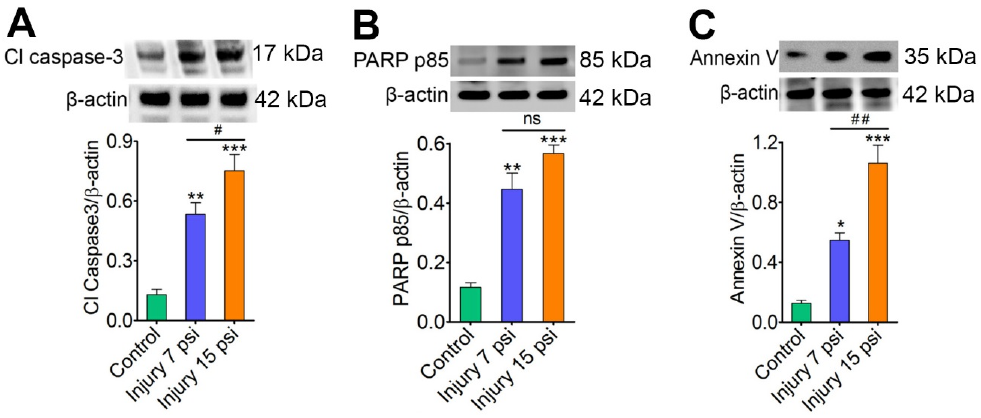
Figure 1. TBI induces apoptosis via caspase ‐ 3 in vivo: ( A–C ). Western blotting of cleaved caspase ‐ 3 ( A ), cleaved PARP (PARP p85) ( B ) and annexin V ( C ) in the brain cortex tissue lysates from uninjured control and FPI animals (7 psi and 15 psi) 9 days after injury. Values are mean ± SEM; n = 4. * p < 0.05, ** p < 0.01, *** p < 0.001 versus uninjured control; # p < 0.05; ## p < 0.01 versus 7 psi injury.